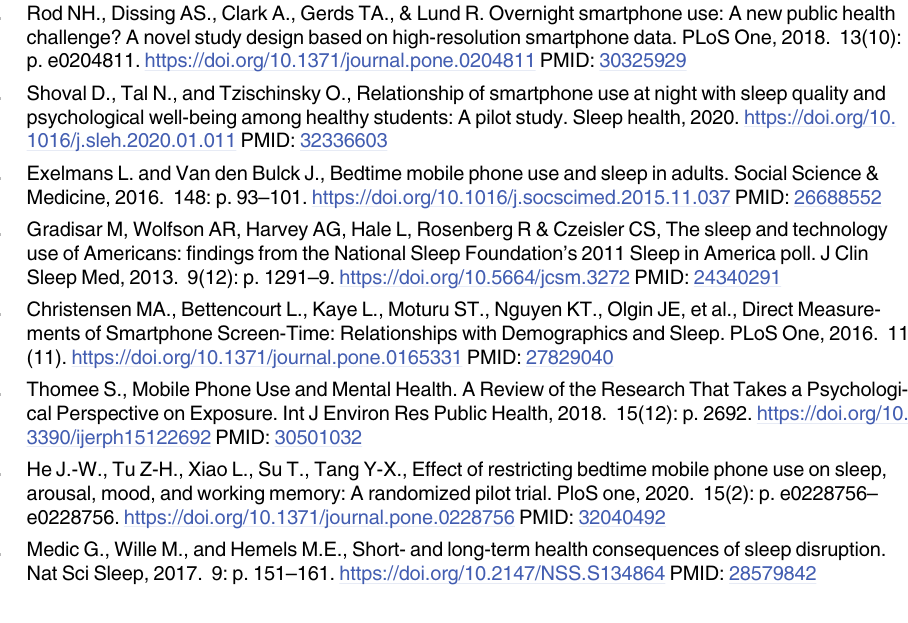
S1 Table. Characteristics of individuals who participated in the follow-up study and indi- viduals who did not participate in the follow-up study. S2 Table. Baseline night-time smartphone use and socio-demograhic